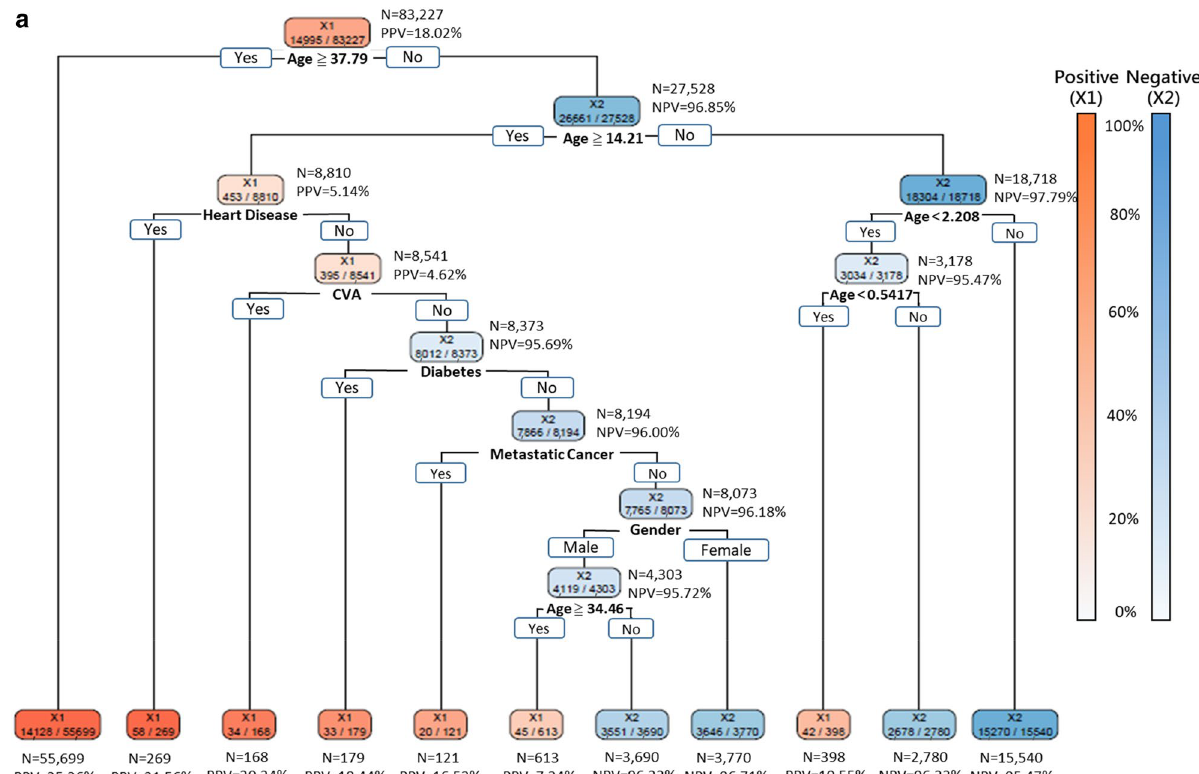
Figure 3. Decision trees generated with 6 features at three sensitivities (95%, 90%, 85%). ( a ) The decision tree built with the 6 features identified by the proposed DT-based method and delivering 95% sensitivity. ( b ) The decision tree built with the 6 features identified by the proposed DT-based method and delivering 90% sensitivity. ( c ) The decision tree built with the 6 features identified by the proposed DT-based method and delivering 85% sensitivity. TP true positive, TN true negative, FP false positive, FN false negative, PPV positive predictive value = TP/(TP + FP), NPV negative predictive value = TN/(TN +